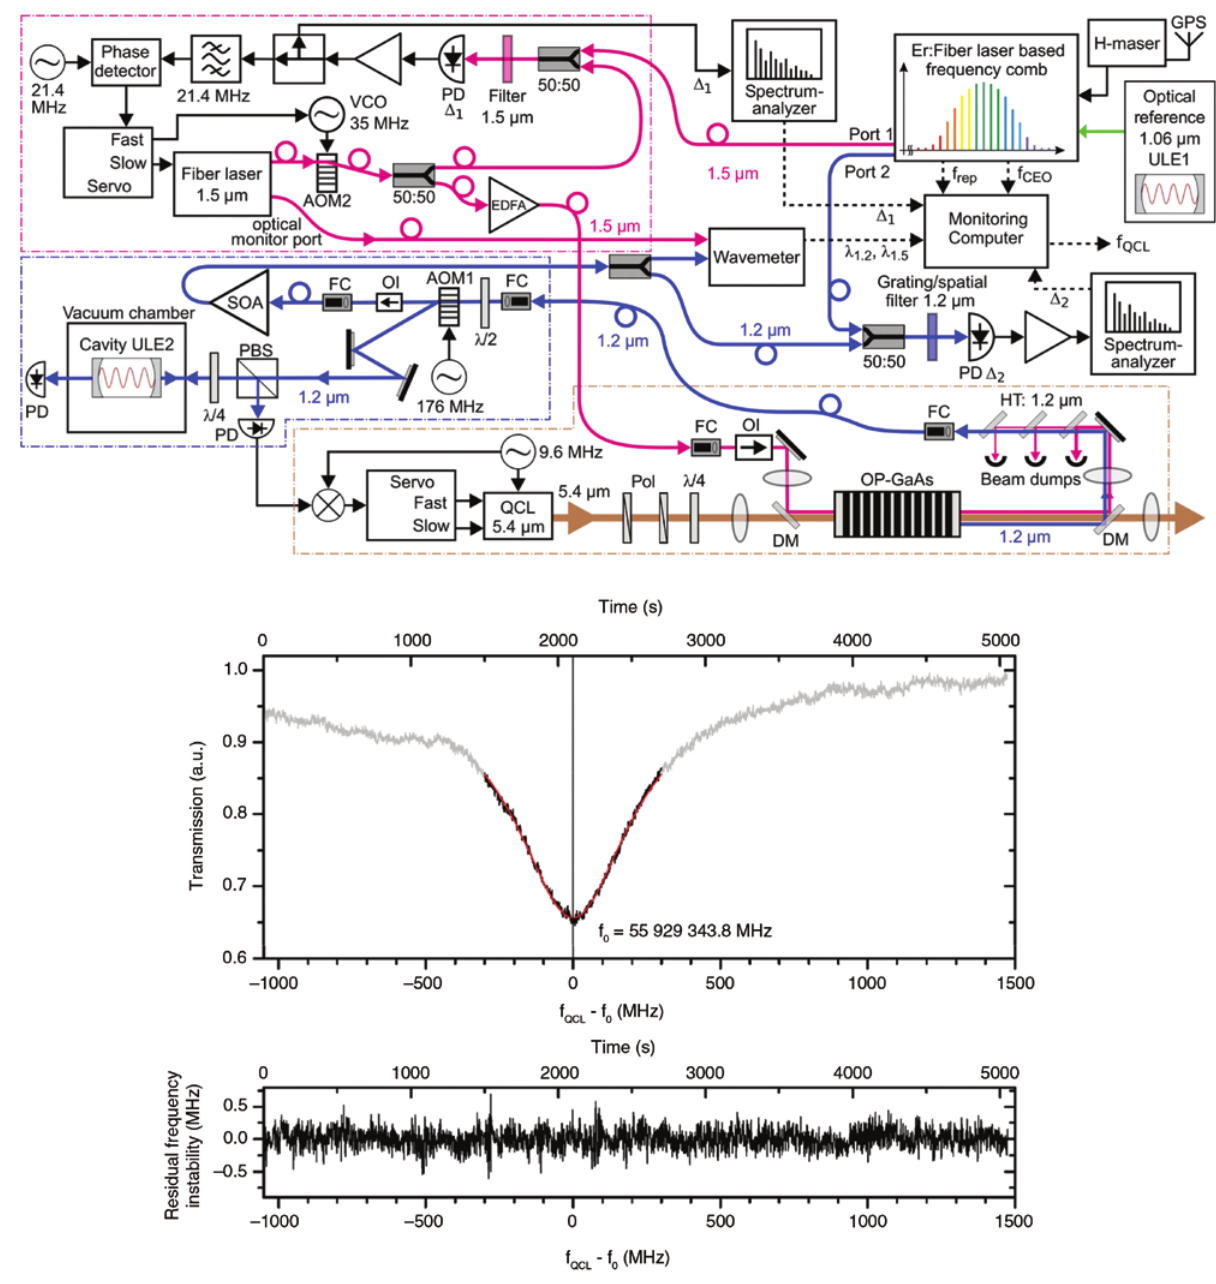
O transition. Figure 5: Example of an upconversionsetup and absorption profile of a n N 2 Top: Hansen et al. [57] report an upconversion setup using a 5.4- μ m emitting QCL. Pink, fiber laser wave at 1.5 μ m; brown, QCL wave at 5.4 μ m; blue, sum frequency wave at 1.2 μ m. The spectrum analyzers are referenced to the H-maser. Reprinted with permission from [57], copyright 2015. Bottom: Absorption profile of N O line around 5.36 μ m. The central part of spectrum is fitted using a Voigt profile (red line). 2 Bottom frequency residual instability during the frequency scan. Reprinted with permission from [58], copyright